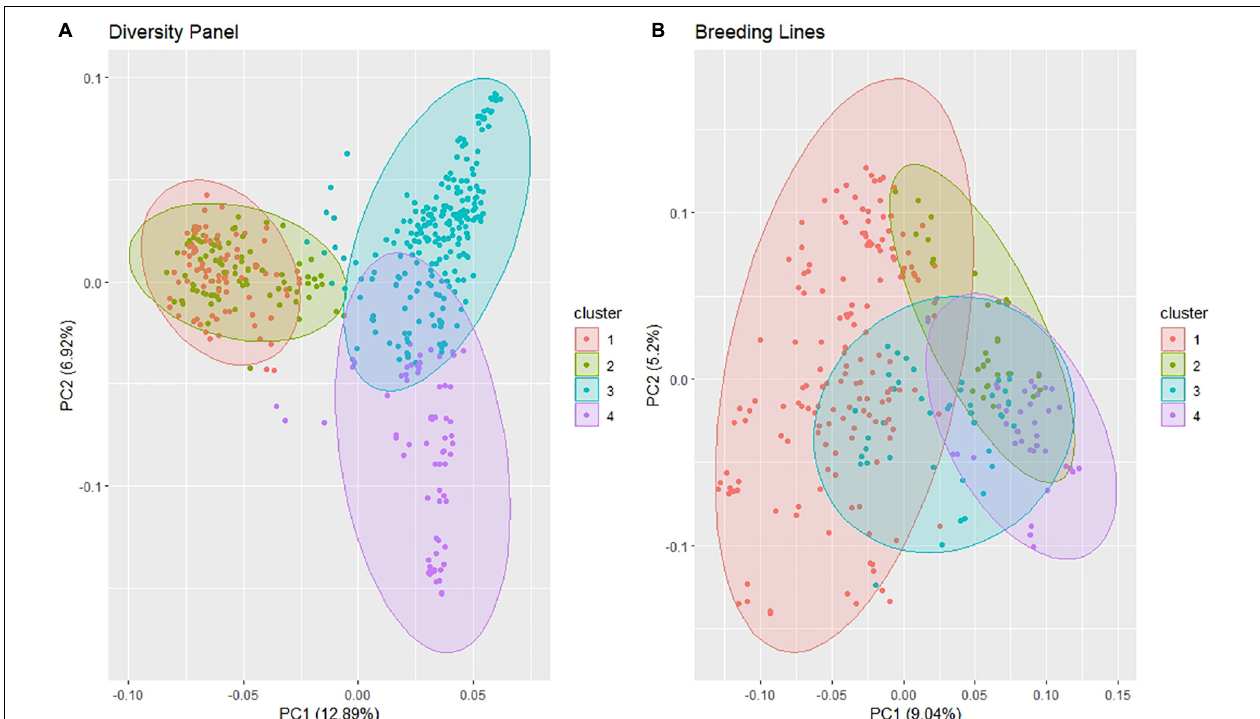
FIGURE 2 | Principal component (PC) biplot of single-nucleotide polymorphism (SNP) genotyping-by-sequencing (GBS) markers and k -means clustering from the (A) diversity panel and (B) breeding line population consisting of the F 3 : 5 trial.